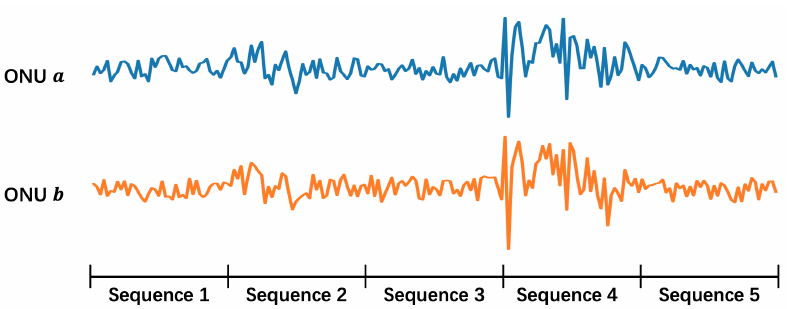
Figure 6. Max voting from sequences to ONUs. Perturbation occurs randomly and occasionally, so we choose the sequence pair with the most similarity as the scores of ONU